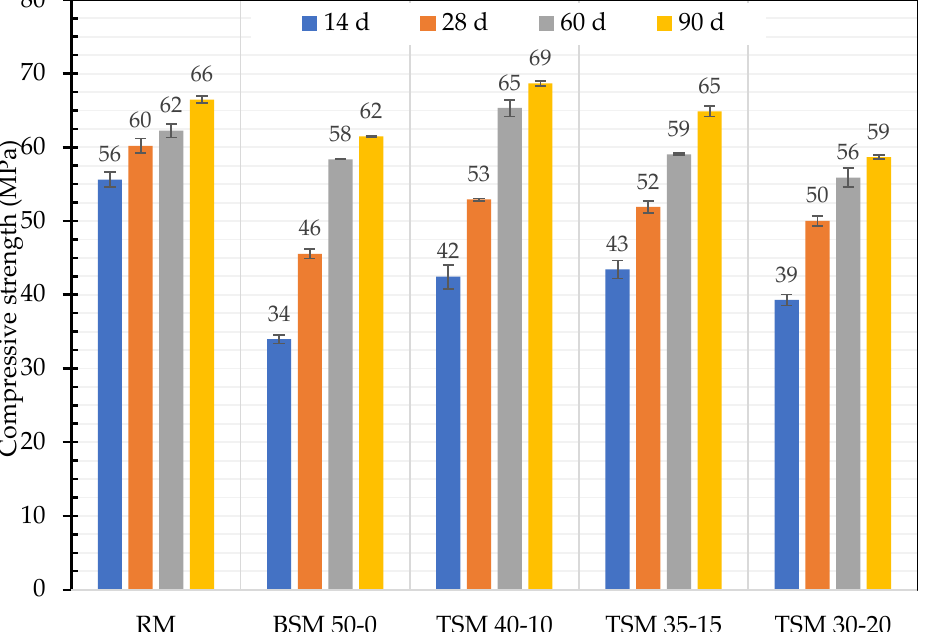
Figure 5. Compressive strength of RM, BSM 50-0, TSM 40-10, TSM 35-15, and TSM 30-20 mortars at 14, 28, 60, and 90 days.